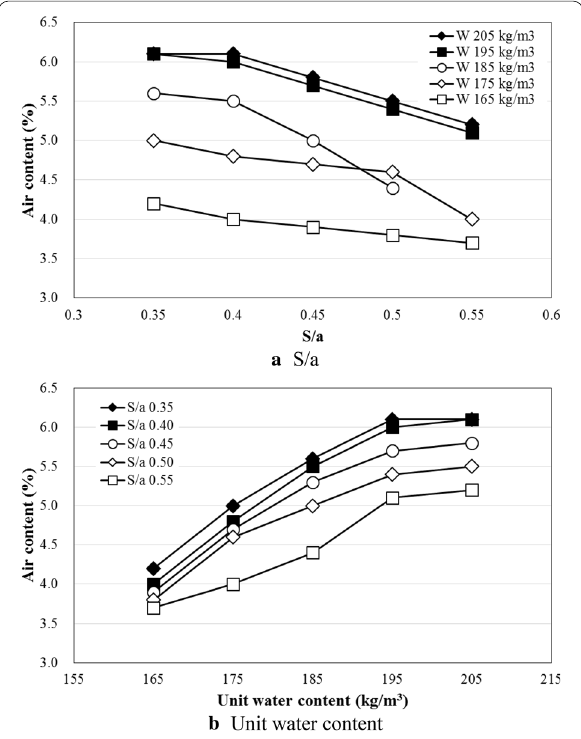
Fig. 11 Effects of S/a and unit water content on air content of high‑strength concrete